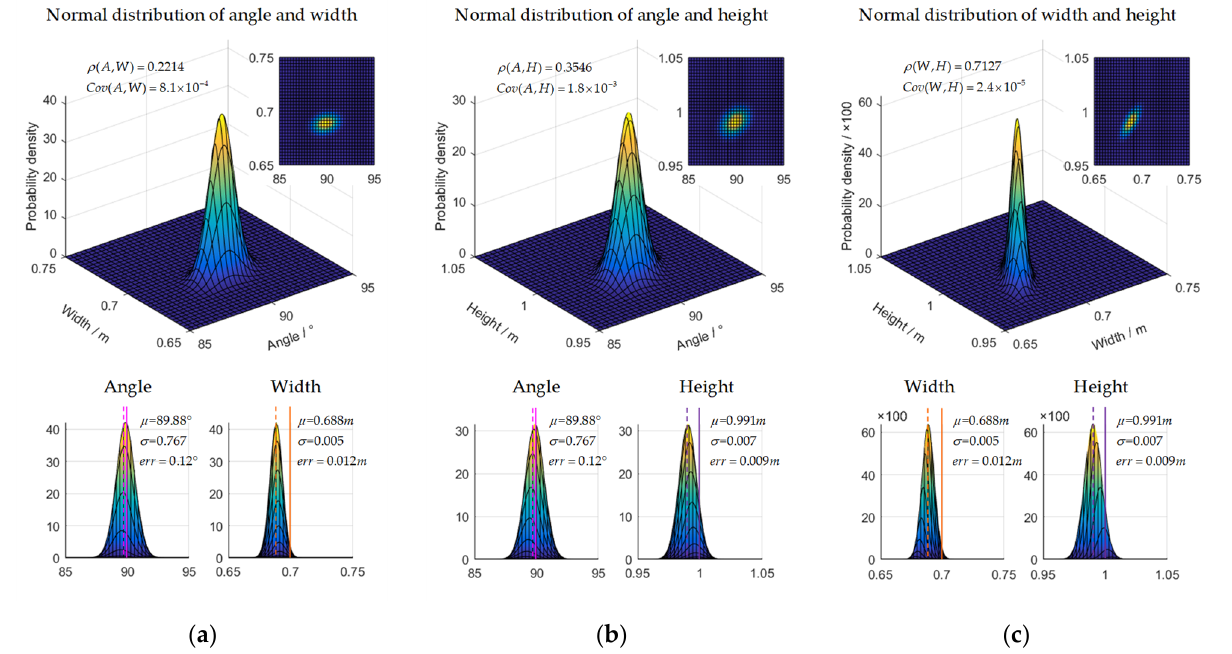
Figure 10. The size fitting analysis of each side and angle of the calibration board, the solid line represents the true value, and the dashed line represents the fitted value. ( a ) Fitting distribution of angle and width. ( b ) Fitting distribution of angle and height. ( c ) Fitting distribution of width and height.